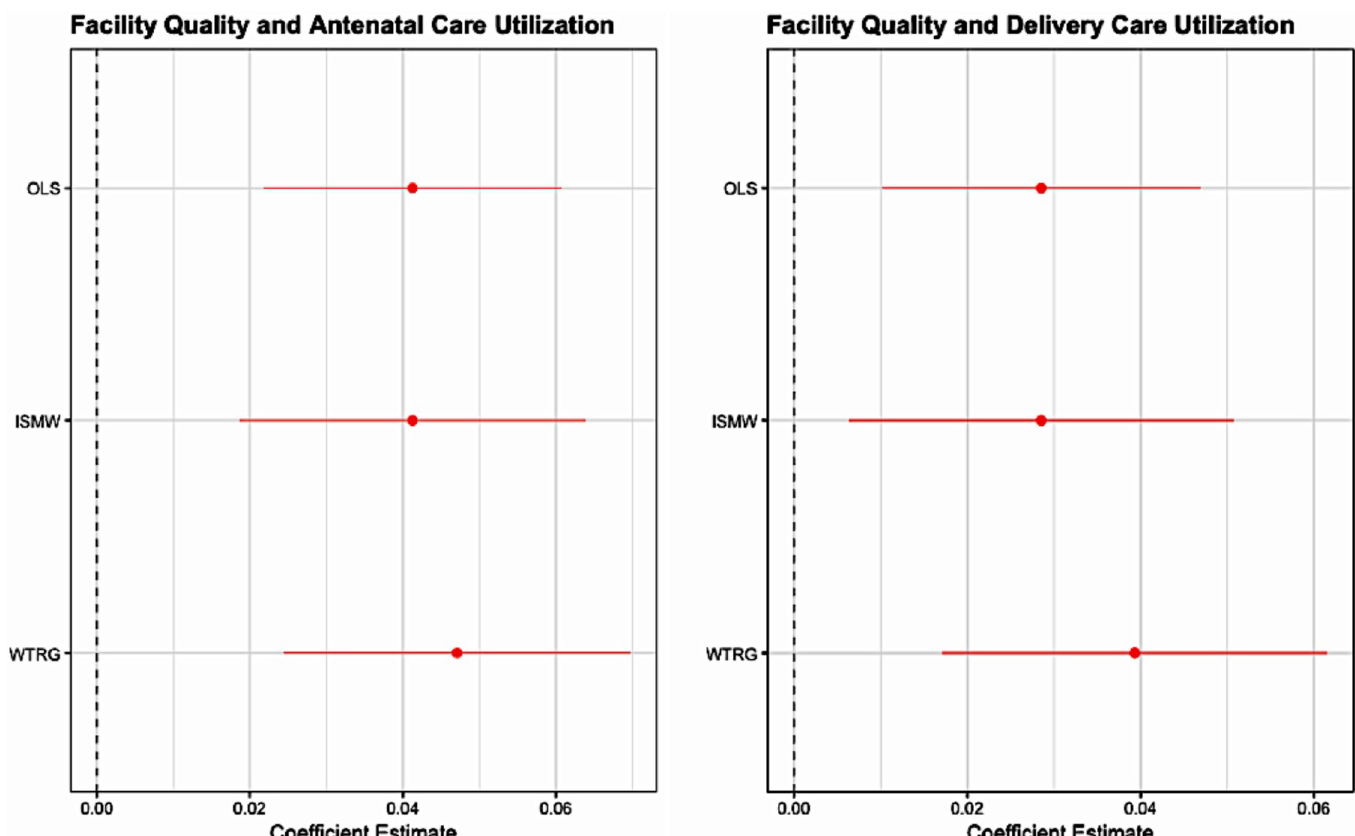
Fig 1. Facility quality and obstetric care utilization. The figure shows the OLS, ISMW, and WTRG estimates and 95% confidence intervals of the relationship between facility quality and antenatal and delivery care utilization based off n = 2,140 deliveries that occurred within 1 year of the facility survey.